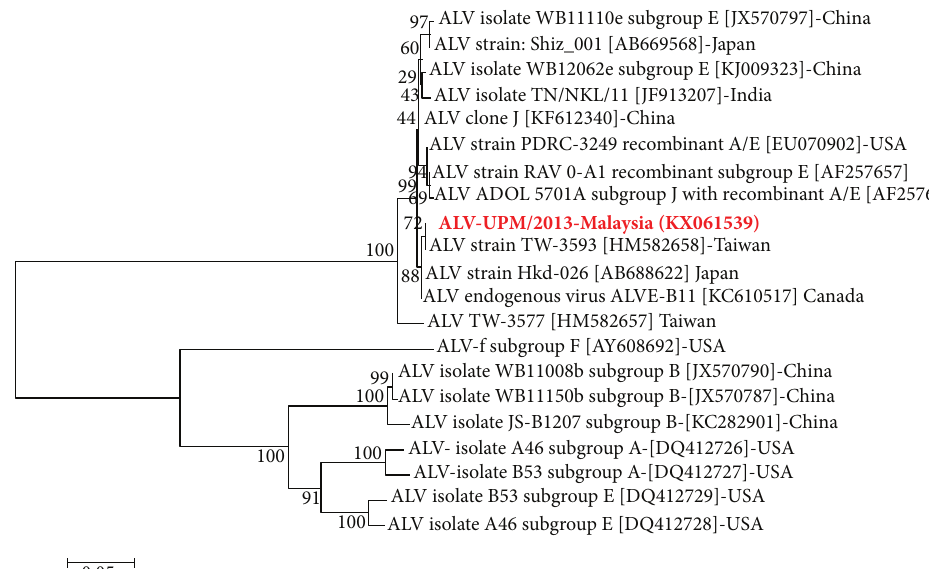
Figure 4: Neighbor-joining phylogenetic analysis using partial nucleotide sequences of the ALV envelope gp85 glycoprotein gene. Malaysian ALV isolate is presented in bold red ink. The confidence level of the inferred tree was determined using 1000 bootstrap. Evolutionary analysis was conducted in MEGA6